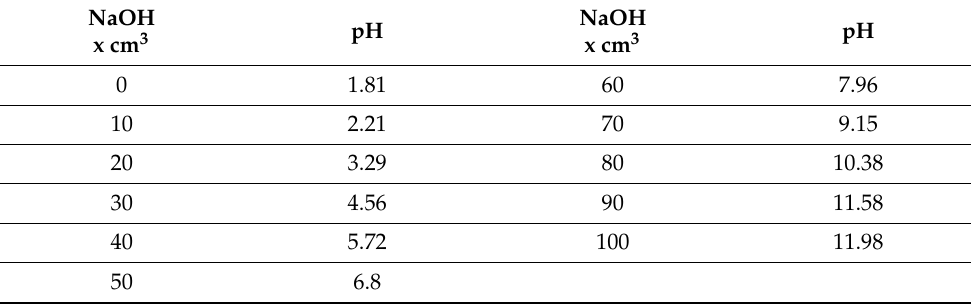
Table 4. Substances used to study the effect of ionic strength on the stability of samples of Se NPs. Concentration of the Substance Names of Substances